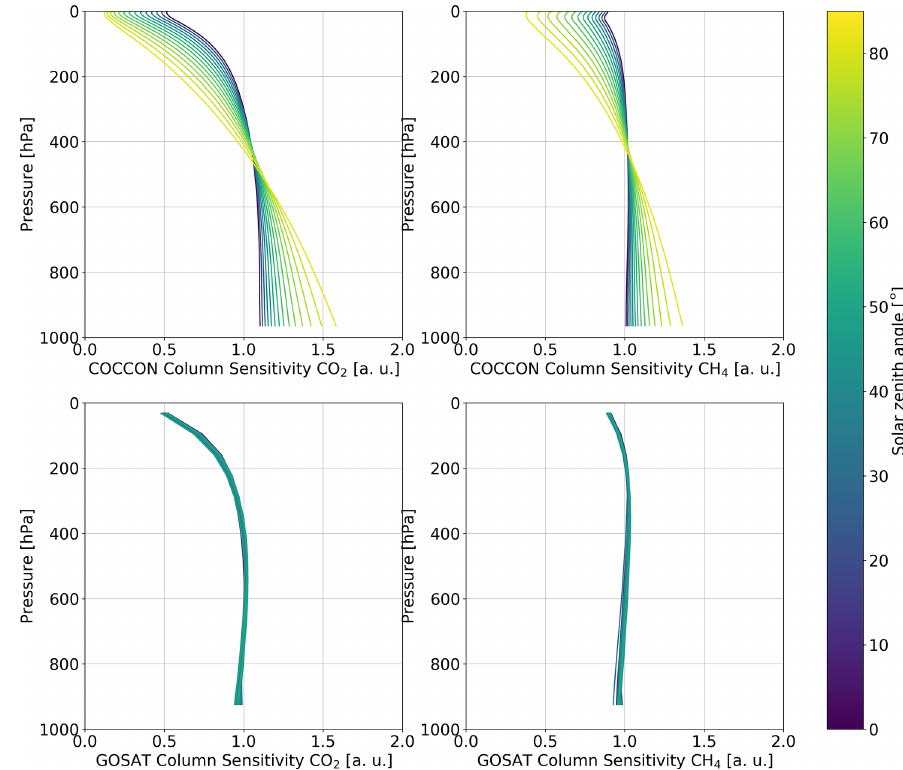
Figure 10. XCO 2 and XCH 4 column-averaging kernels for the COCCON Gobabeb and GOSAT observations. The color bar denotes the SZA. For the COCCON instrument, SZAs from 0 to 85 ◦ are depicted, whereas for GOSAT only the averaging kernels for the actual measurements are shown, with SZAs approximately between 10 and 50 ◦ .